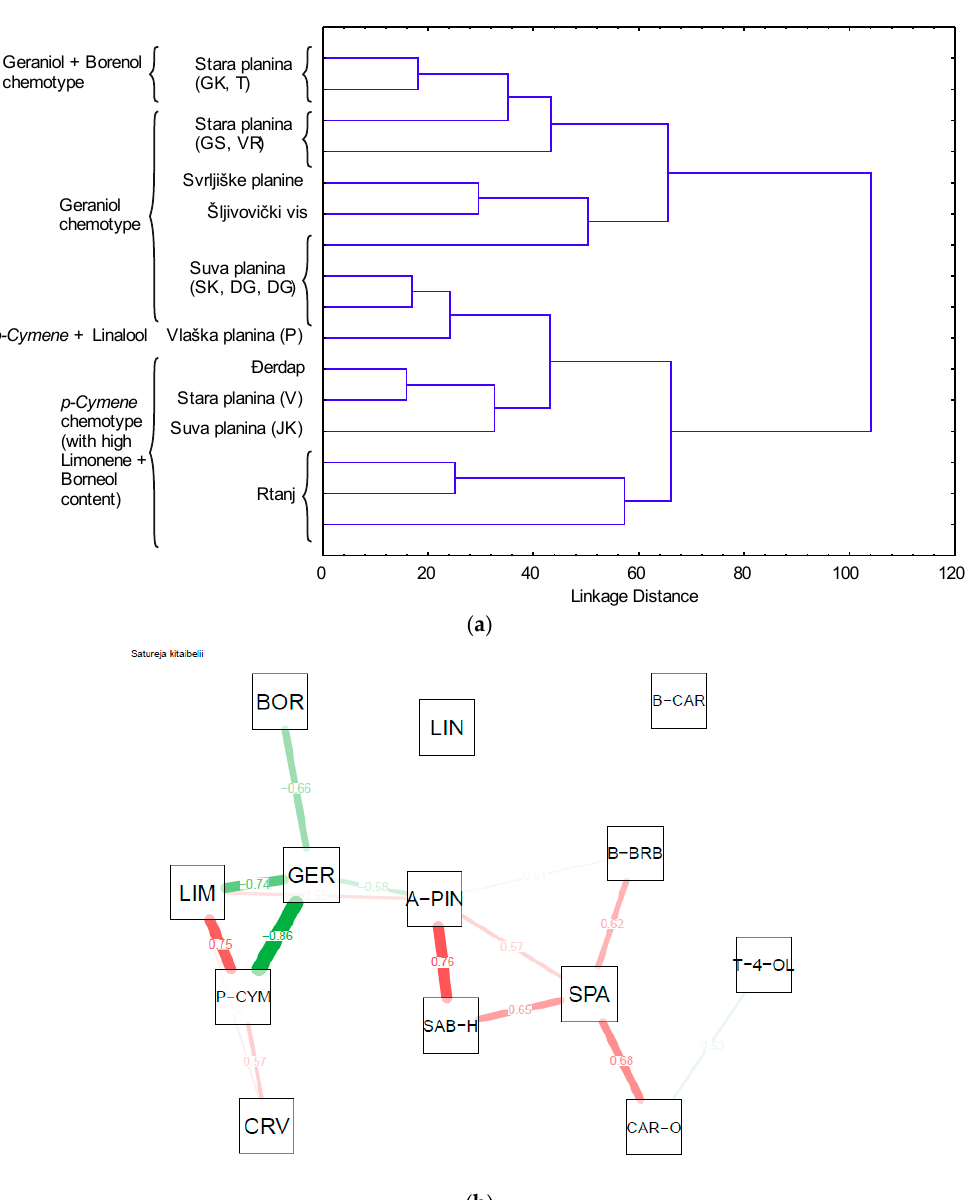
Figure 1. ( a ) Dendogram of the EO constituents of S. kitaibelii from this study and from literature reports (the samples are marked according to Table 3); ( b ) correlation network based on S. kitaibelii